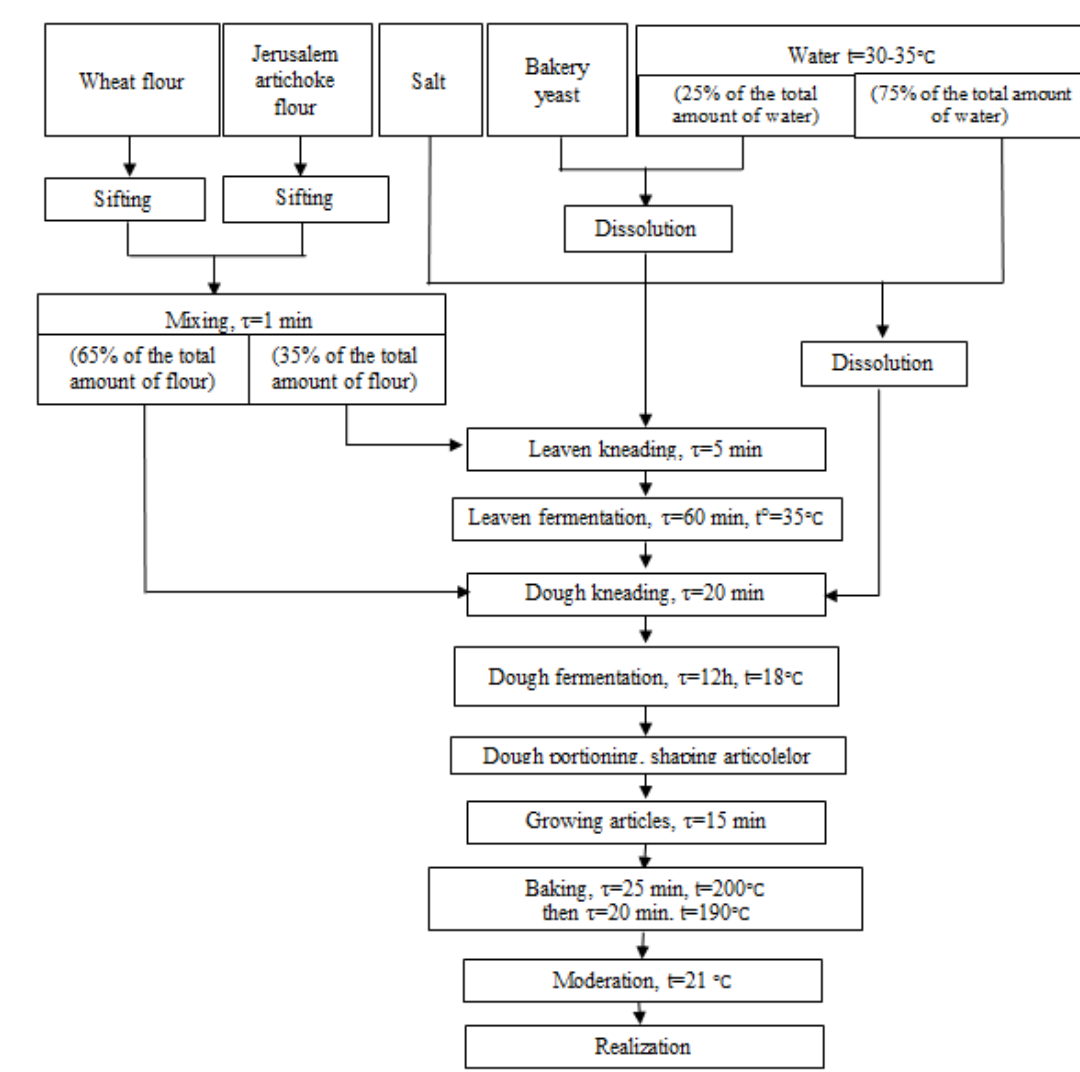
Figure 3. General scheme of bread making [developed by the